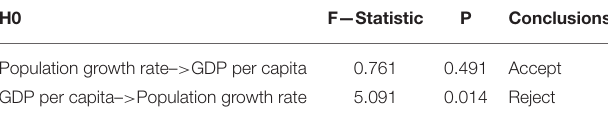
TABLE 9 | Granger causality test (at 5% test level).